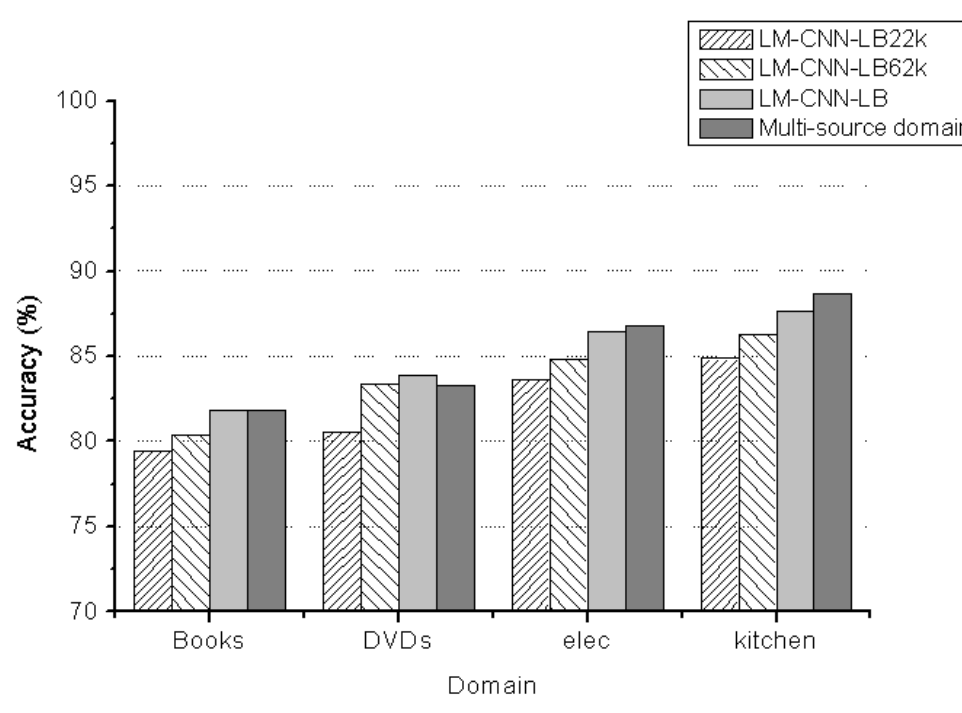
Figure 3. Effect of corpus size and multi-source domain.